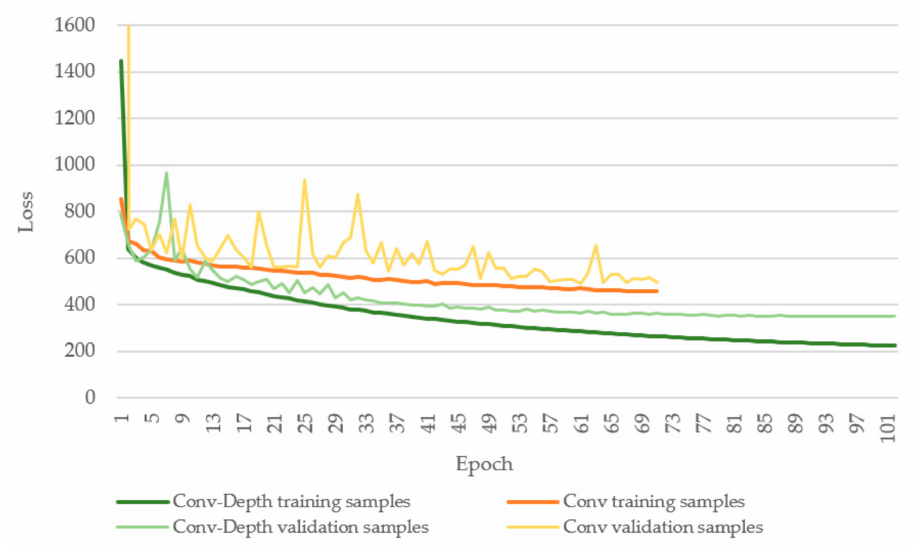
Figure 6. Loss convergence comparison: conv-depth block vs. conv only for context-based ResU-Net when using 60 m images with f c feature dimensions (2 ×